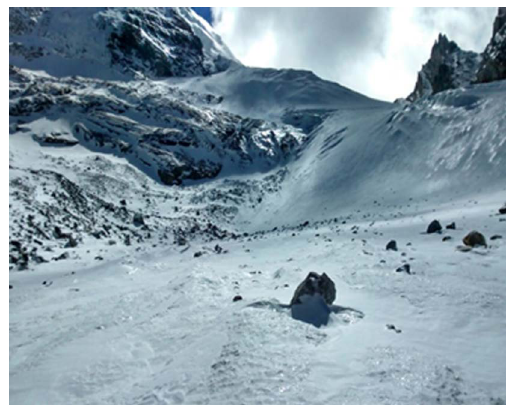
Fig. 7. Kanchengayao